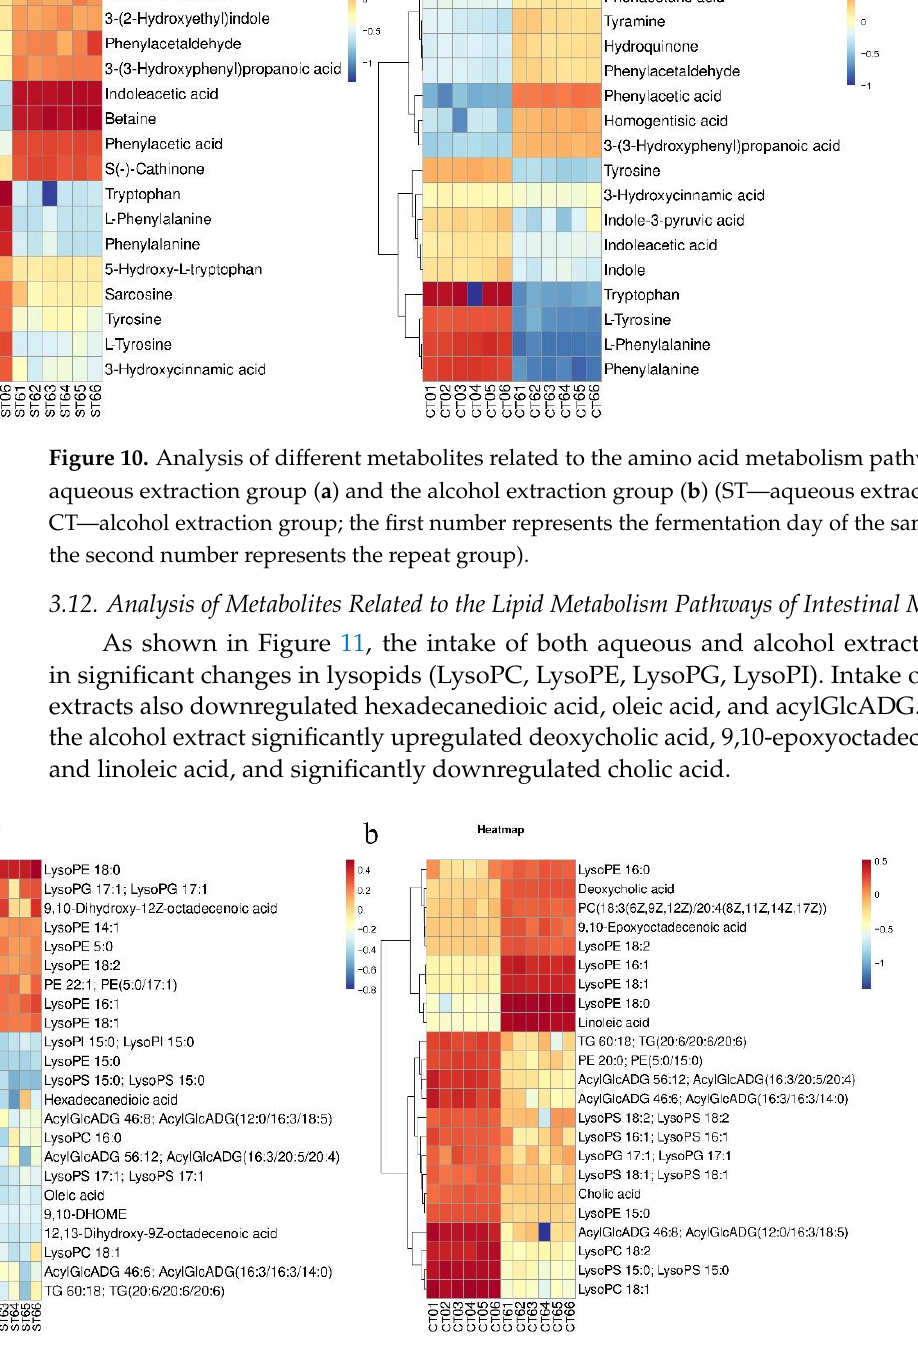
Figure 11. Analysis of different metabolites related to lipid metabolism pathways in the aqueous extraction group ( a ) and the alcohol extraction group ( b ) (ST—aqueous extraction group; CT—alcohol extraction group; the first number represents the fermentation day of the sample added; the second number represents the repeat group).